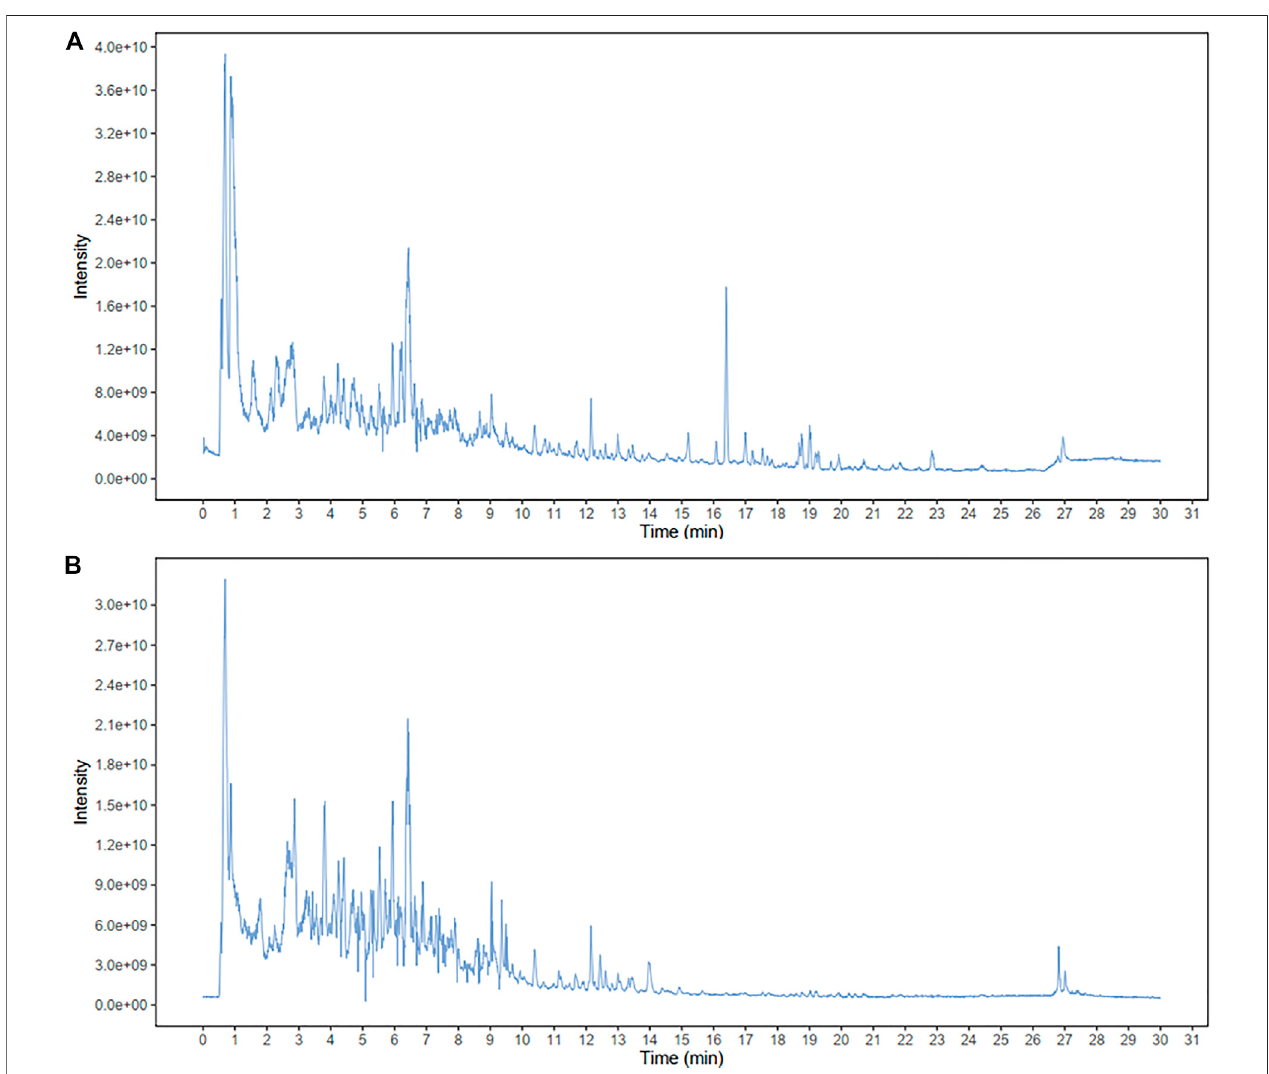
FIGURE 2 | Identi fi cation of major components of APE examined by UPLC-MS/MS.The positive (A) and negative (B) ion chromatograms of APE are shown as indicated. APE, Alhagi pseudalhagi extract.